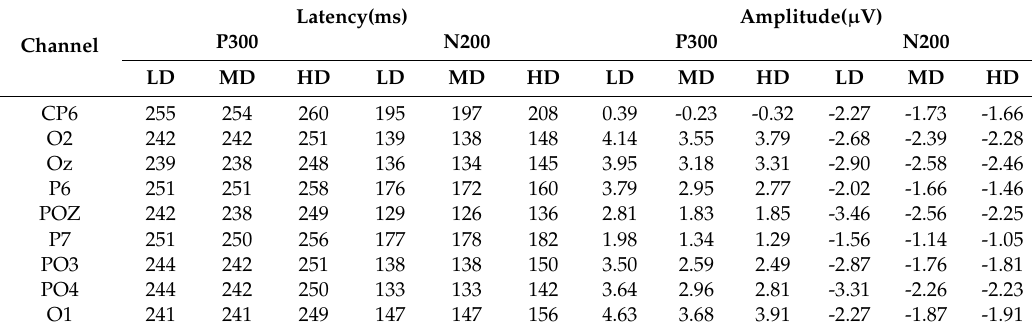
Table 5. Latency and amplitude changes of some channels.